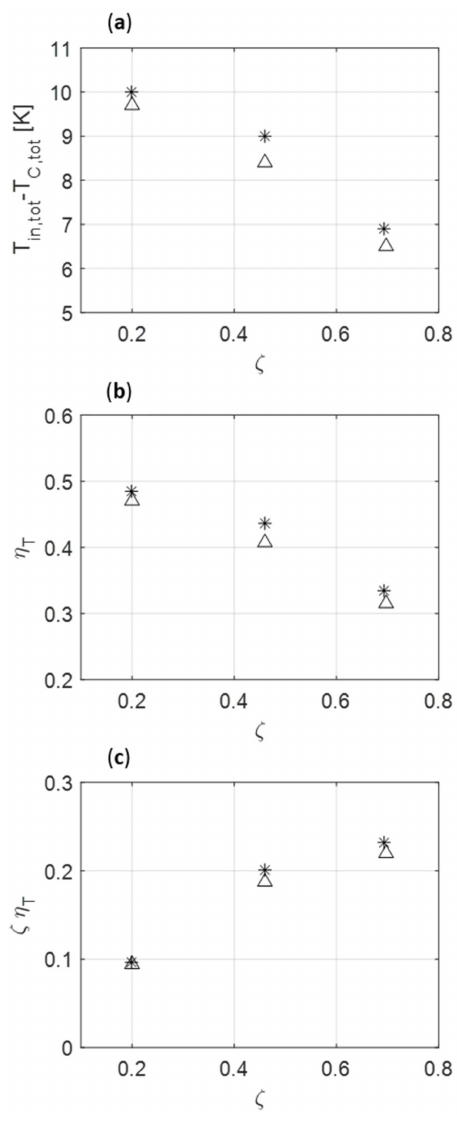
Figure 11. Metrics of performance of vortex tubes: ( a ) temperature separation at the cold outlet, ( b ) isentropic temperature efficiency, ( c ) non-dimensional cooling capacity. Stars, highest performing (among studied setups) case C; triangles, original case